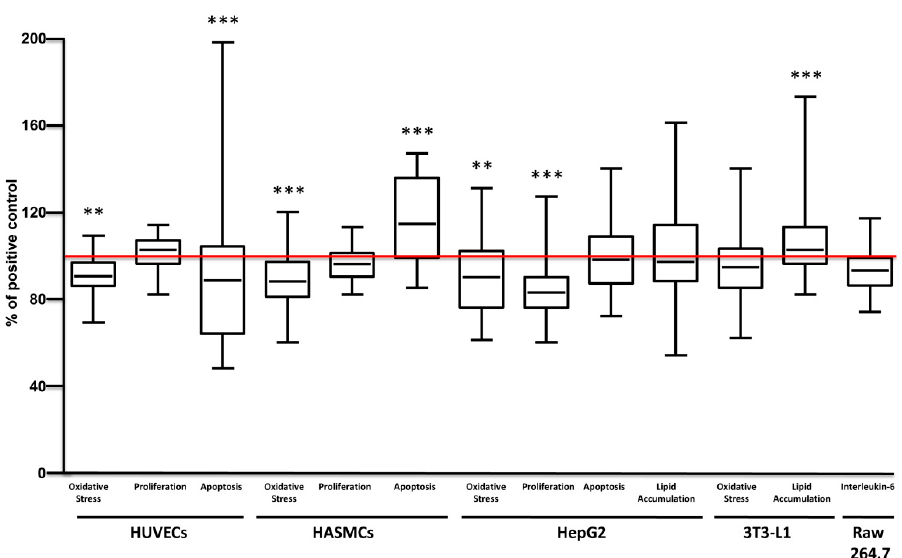
Figure 4. Global bioactivity of carrot extracts on cell models. Each box and whisker plot represent the effect of carrot extracts in the indicated process (Oxidative stress, cell proliferation, cell apoptosis, lipid accumulation, interleukin-6 production) and cell type (HUVECs, HASMCs, HepG2, 3T3-L1, Raw 264.7) independently from solvent, concentration, variety and growing condition. Results were expressed as percentage of positive control (red line). Statistical analyses were performed by one-way ANOVA and Bonferroni post hoc test, ** p < 0.01, *** p < 0.001 vs